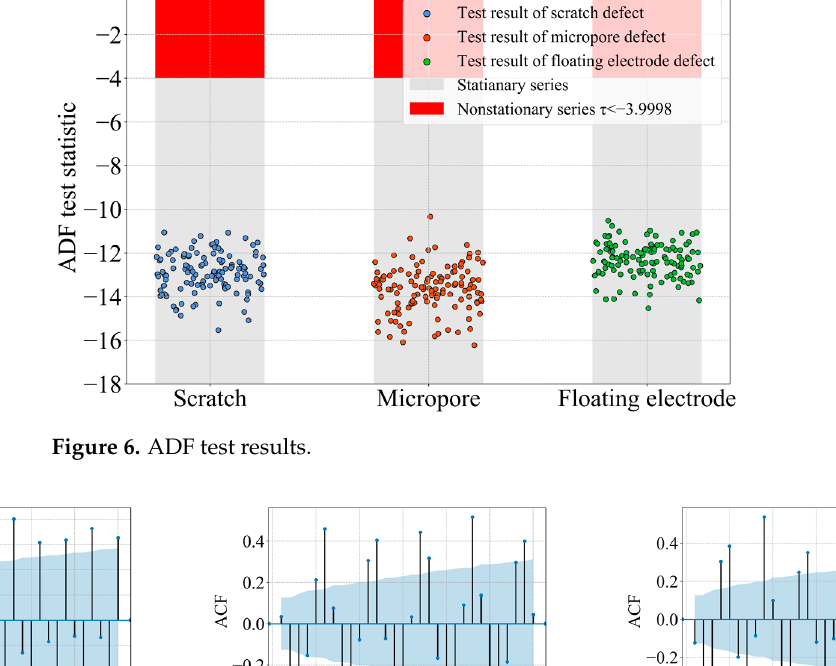
Table 1. Criterion for order determination of ARMA model.